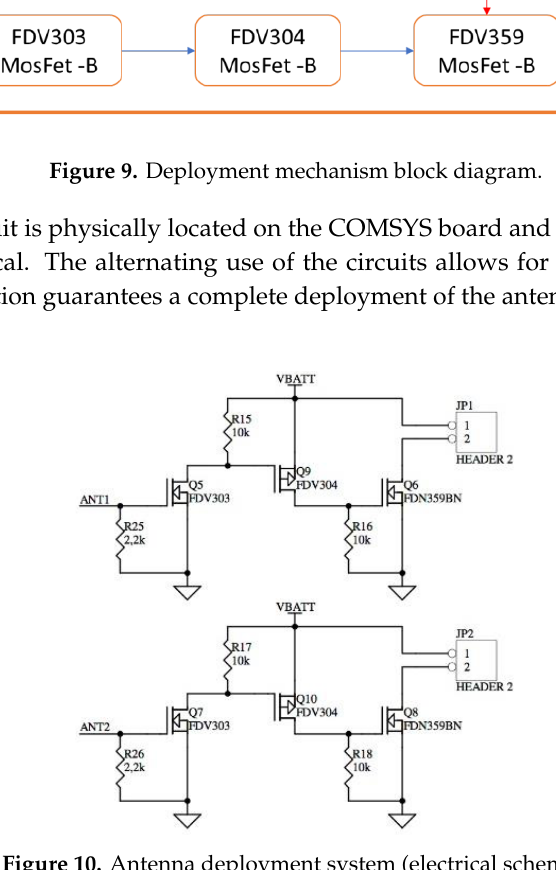
Figure 8. Antenna deployment mechanism with the antenna folded around.